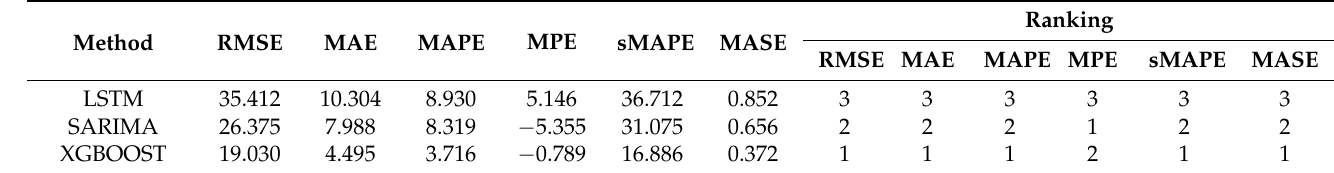
Table 2. Results & ranking of the performance metrics.